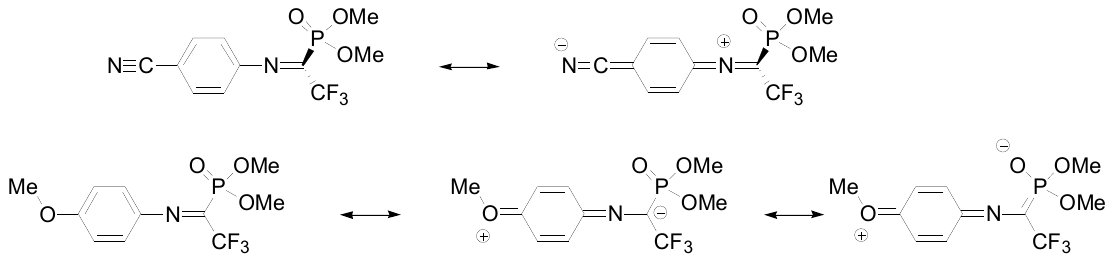
Figure 10. Optimized structures of the Z- and E-isomers of compounds 6 and 7 ( 6-Z , 7-Z and 6-E , 7-E , respectively), and the structures corresponding to the transition states of the isomerization reaction ( 6-TS and 7-TS ).